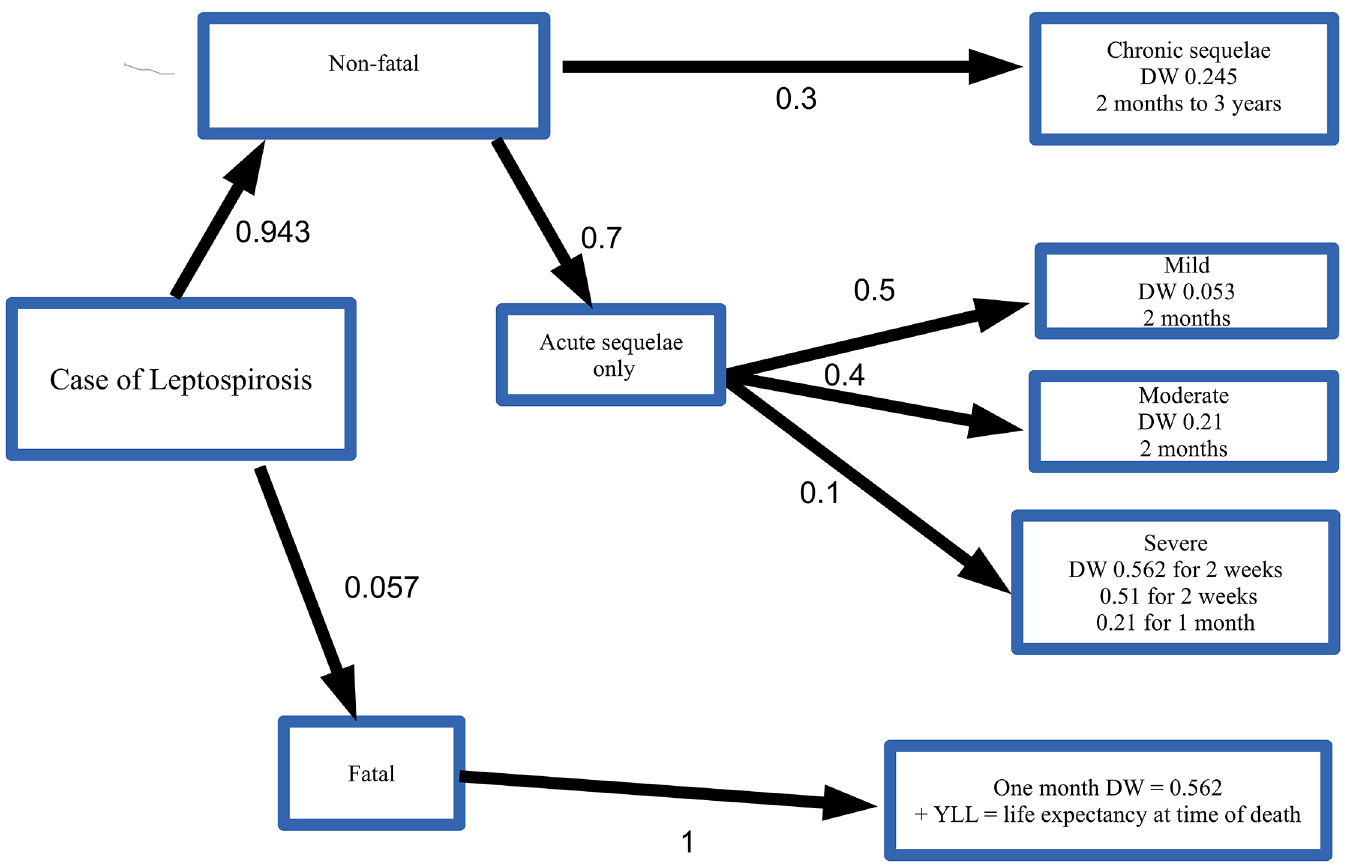
Fig 1. Decision tree to assign probabilities and DWs for sequelae of